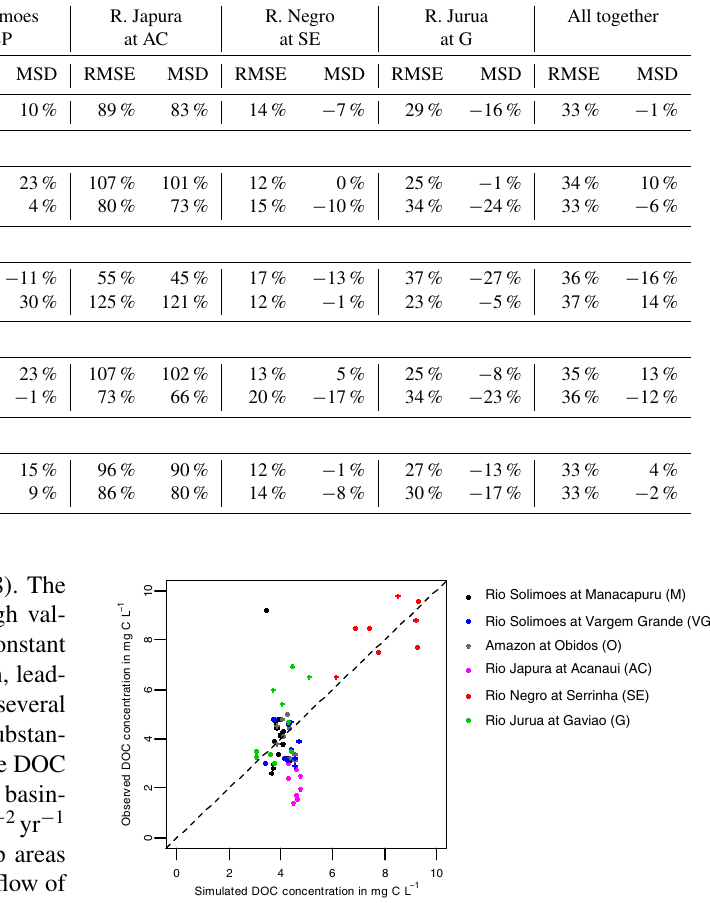
Figure 13. Observed versus simulated DOC concentrations ( R 2 = 0 . 45, RMSE = 1.45mgCL − 1 ). For simulated values, each point represents the average during the year and month for which field data are available. The dashed line represents the 1:1